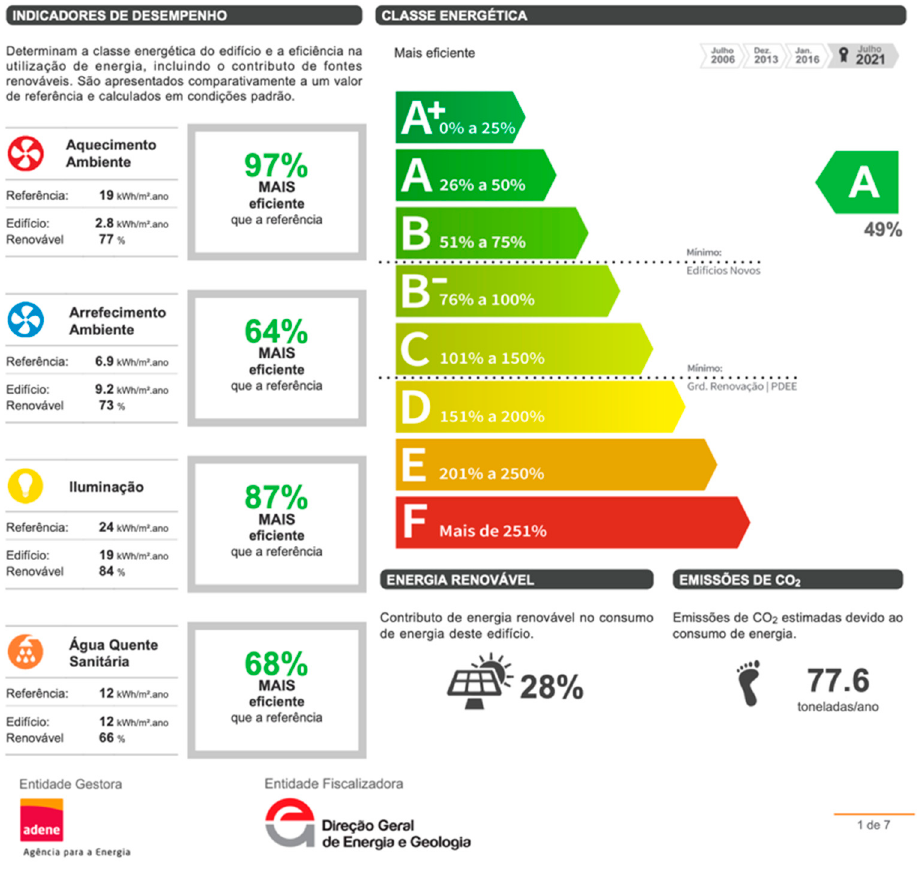
Figure 12. Energy certi fi cate. Building in Porto. © ADENE.